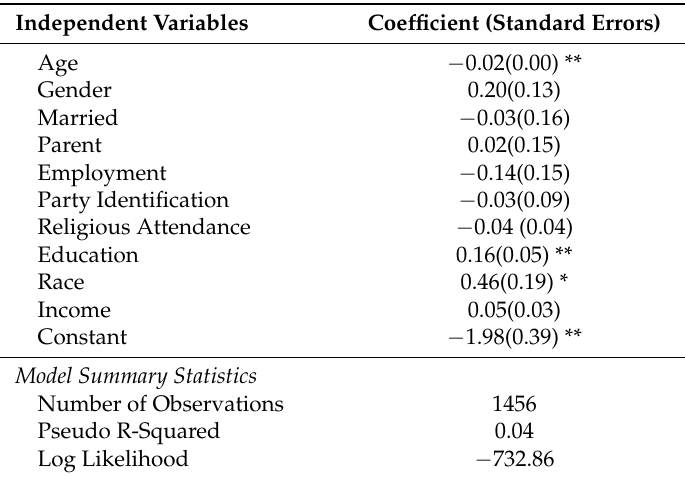
Table 3. Logistic regression evaluating which individuals are most likely to post online comments in 2012 (Pew Internet & American Life Project